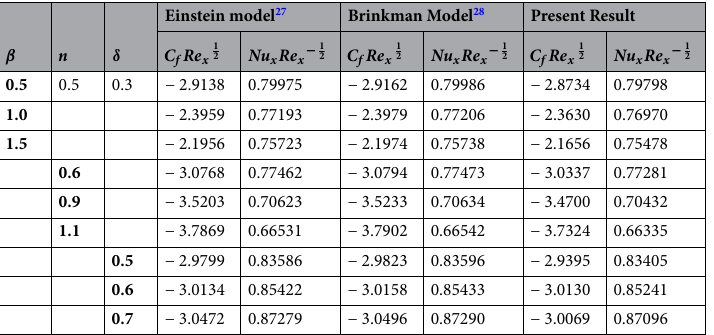
Table 2. Comparison of the values of C f Re x values are in bold.